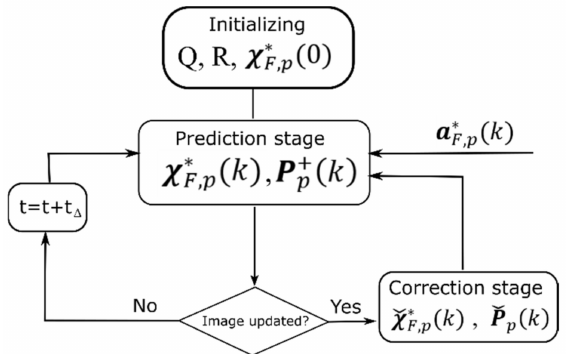
Figure 4. The block diagram of Kalman filter for prediction of the target point movement relative to the